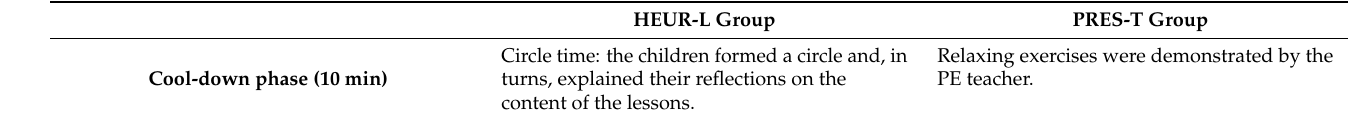
Table 1. Cont. HEUR-L Group PRES-T Group Circle time: the children formed a circle and, in Cool-down phase (10 min) turns, explained their reflections on the content of the lessons.